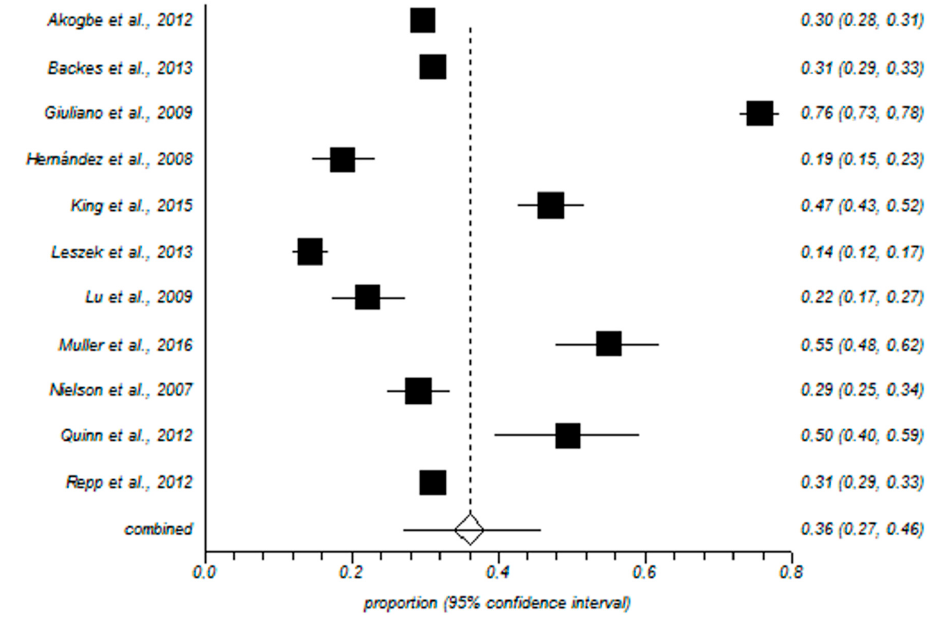
Figure 3. Forest plot of high-risk HPV prevalence. High risk HPV prevalence informed by each